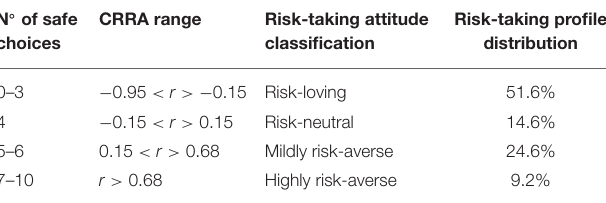
TABLE 2 | Risk-taking profiles toward